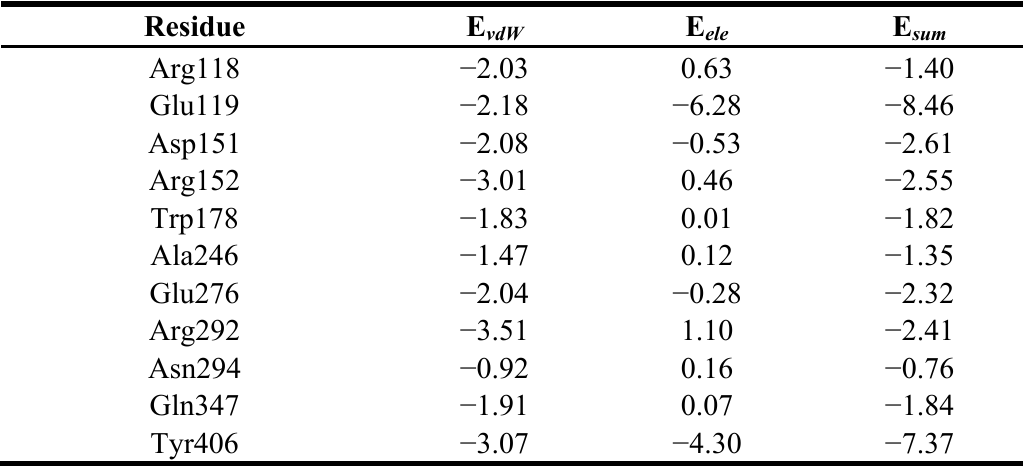
Table 3. The vdW, electrostatic and sum interaction energies (E patchouli alcohol and the key active-site residues of NA protein a